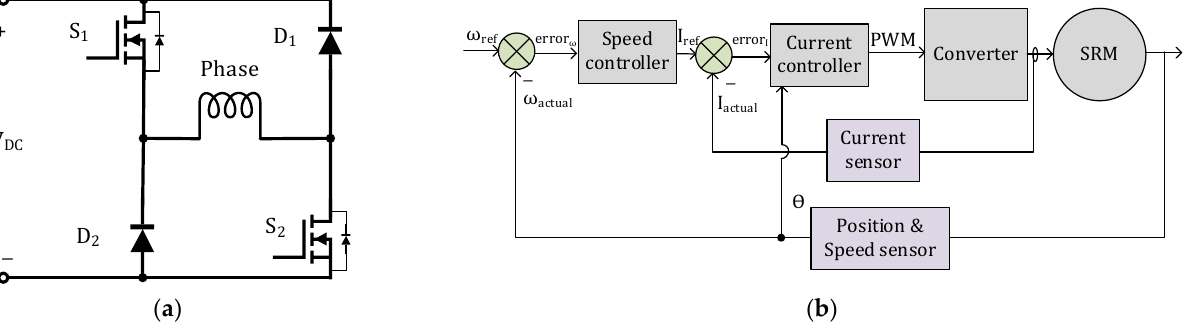
Figure 16. SiC driver and the control system: ( a ) SiC converter for each phase; ( b ) dual-loop control system diagram.